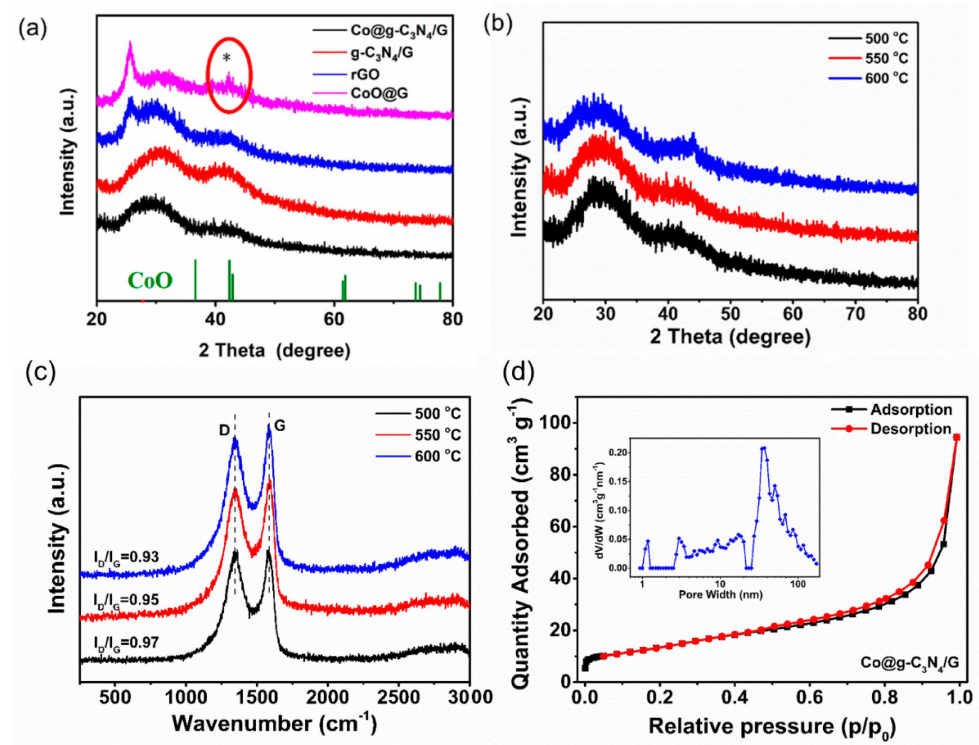
Figure 1. ( a , b ) XRD spectra, ( c ) Raman spectra, and ( d ) N 2 adsorption–desorption curve of as- prepared samples (the corresponding pore size distribution curves are inserted in ( d )). The * in Figure 1a is a diffraction peak of CoO in the CoO@G